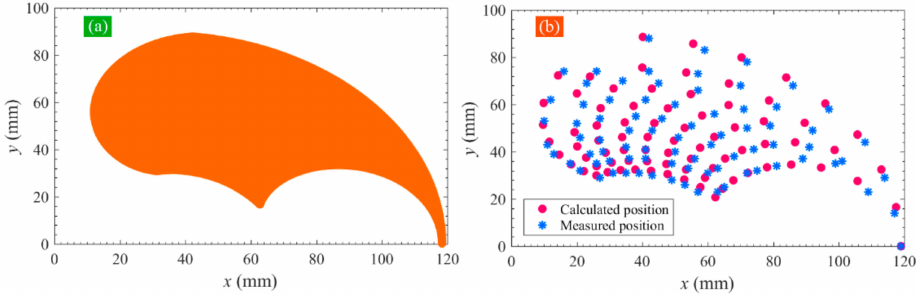
Figure 12. ( a ) Motion range of the proposed SPA predicted by the developed kinematic model and ( b ) comparison of the calculated and measured actuator’s tip